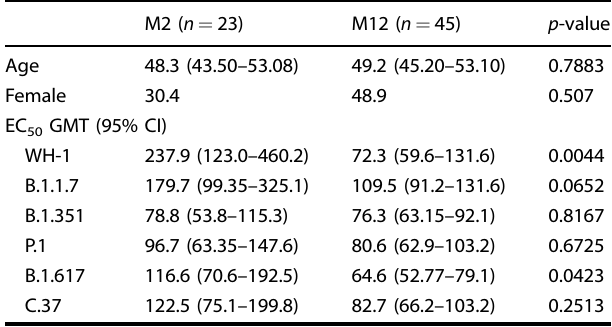
Table 2. Neutralizing-antibody response to WH-1 and 5 variants